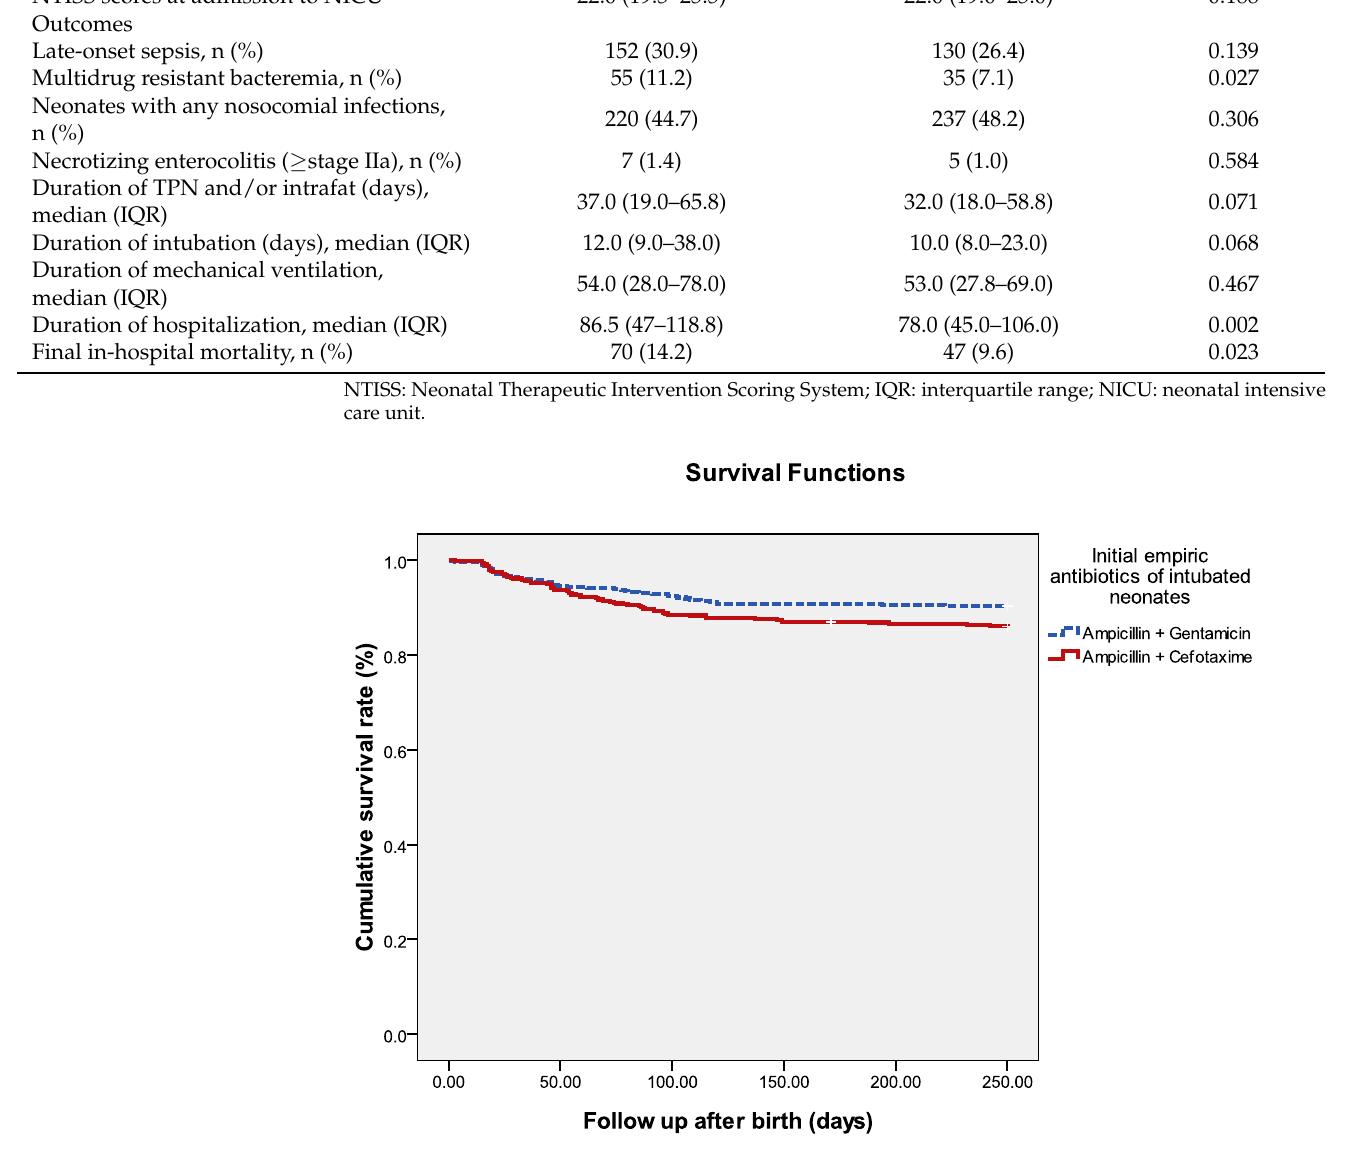
Figure 1. Survival of all neonates with mechanical intubation at birth. The Kaplan–Meier graph is stratified by neonates receiving ampicillin plus cefotaxime and those receiving ampicillin plus gentamicin. The log-rank test = 0.027.